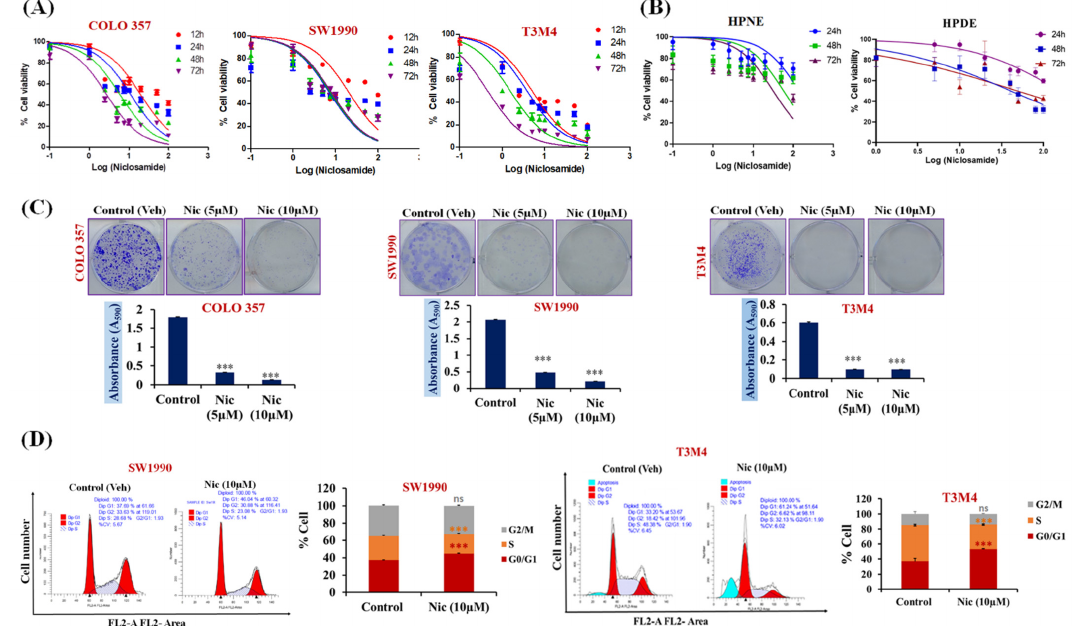
Figure 1. Nic-mediated inhibition of cell growth, colony formation, and G1-phase cell accumulation in pancreatic cancer (PC) cells. ( A , B ) Concentration (100 nM–100 μ M) and time-dependent (12, 24, 48, and 72 h) effect of Nic treatment on the viability of PC cells ( A ) and normal (human pancreatic nestin expressing (HPNE), pancreatic ductal (HPDE)) pancreatic cell lines ( B ) were determined by MTT assay. Values are expressed as mean ± SEM ( n = 5). ( C ) Evaluation of in vitro colony formation capabilities of PC cell lines (COLO 357, SW1990, and T3M4) treated with Nic ~IC 20 (5 μ M); ~IC 50 (10 μ M) (upper panel). Cell colony was then dissolved in 10% glacial acetic acid, and the optical density was measured at 590 nm under a microplate reader. Quantitative analysis of these colonies represented (lower panel) and values are expressed as mean ± standard error of the mean (SEM, n = 5), p values: *** p < 0.001 vs. control, Student’s t -test. ( D ) SW1990 and T3M4 cells - treated with Nic (10 μ M) and stained with propidium iodide (PI) followed by flow cytometry to determine the cell cycle distribution based on DNA content ( left panel). Quantitative analysis of these micrographs was shown as mean ± SEM, p values: *** p < 0.001 vs control ( right panel).